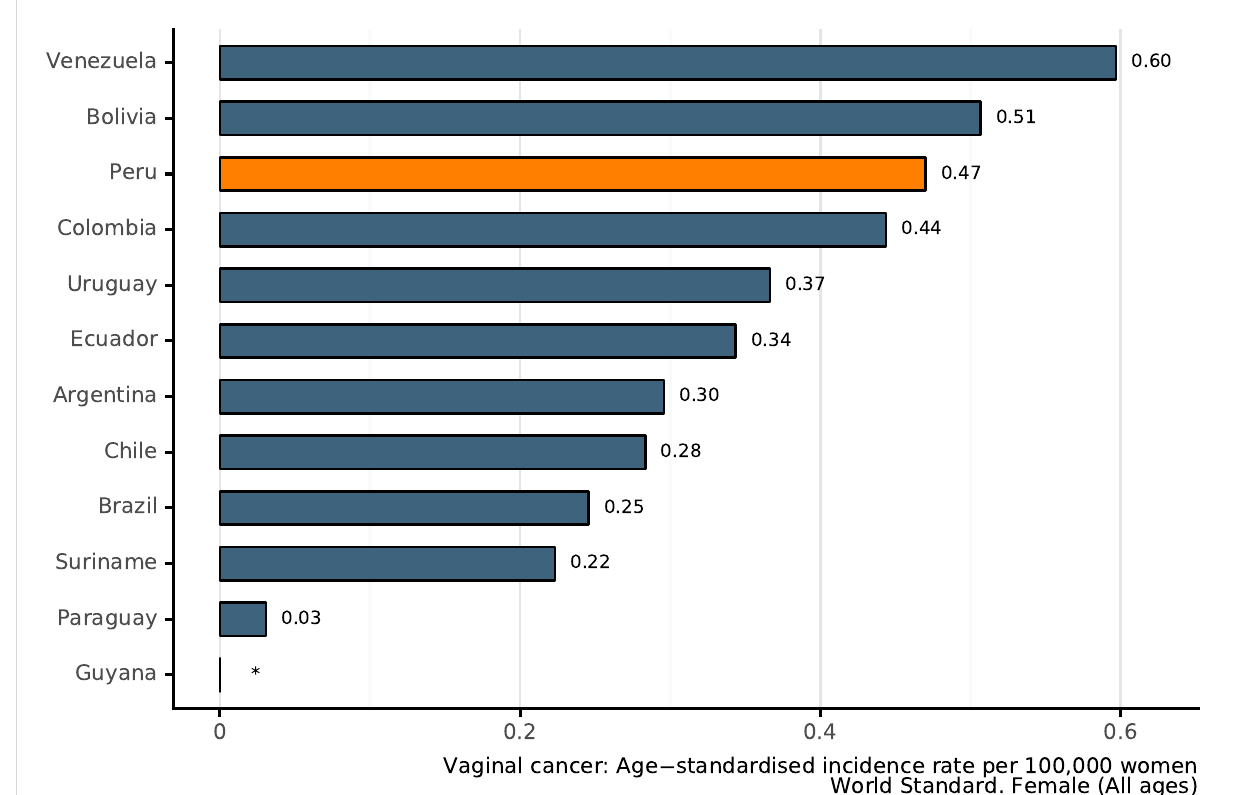
Vaginal cancer: Age standardised incidence rate per 100,000 women World Standard. Female